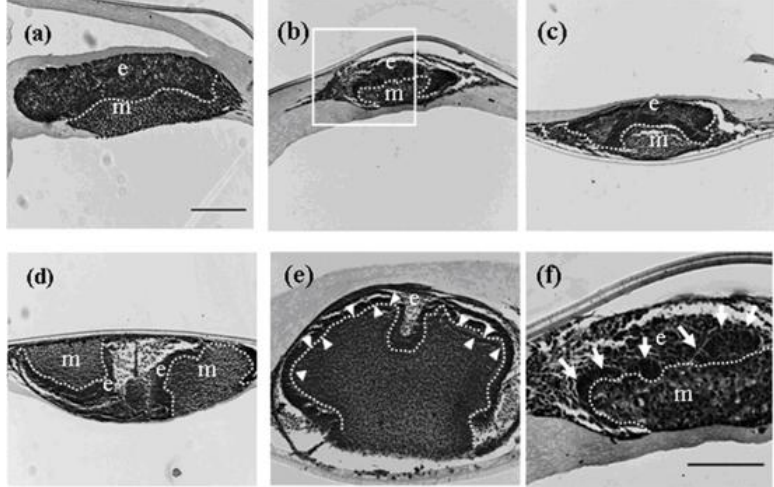
Figure 2. Histology of developing germs reconstructed with mixed epithelial cells (emtg-2 cells: EC = 1:1) and MT on culture inserts. Germs cultured for 1 ( a ), 2 ( b ), 3 ( c ), 5 ( d ) and 7 days ( e ). ( f ) High magnification of the enclosed area in ( b ). Elongated epithelial cells (arrows in f ) were detected after two days in culture. A developing tooth had a very thin dentin-like structure after seven days in culture (e: arrow heads). E: epithelium, m; figure b (cid:177) e are at the same magnification. Scale bar in ( f (cid:12)(cid:3)(cid:76)(cid:86)(cid:3)(cid:20)(cid:19)(cid:19)(cid:3)(cid:541)(cid:80)(cid:17)